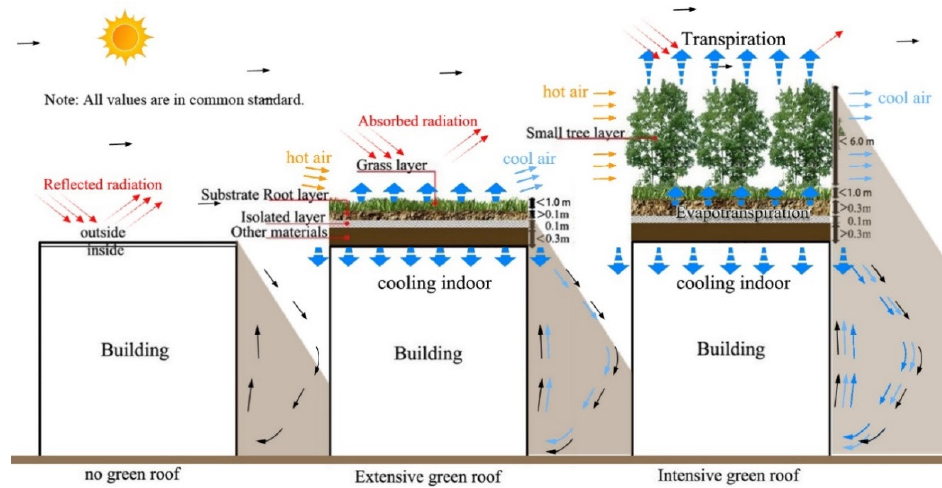
Figure 1. A schematic structure of an extensive green roof and an intensive green roof, and the cooling mechanism in the daytime. mechanism in the